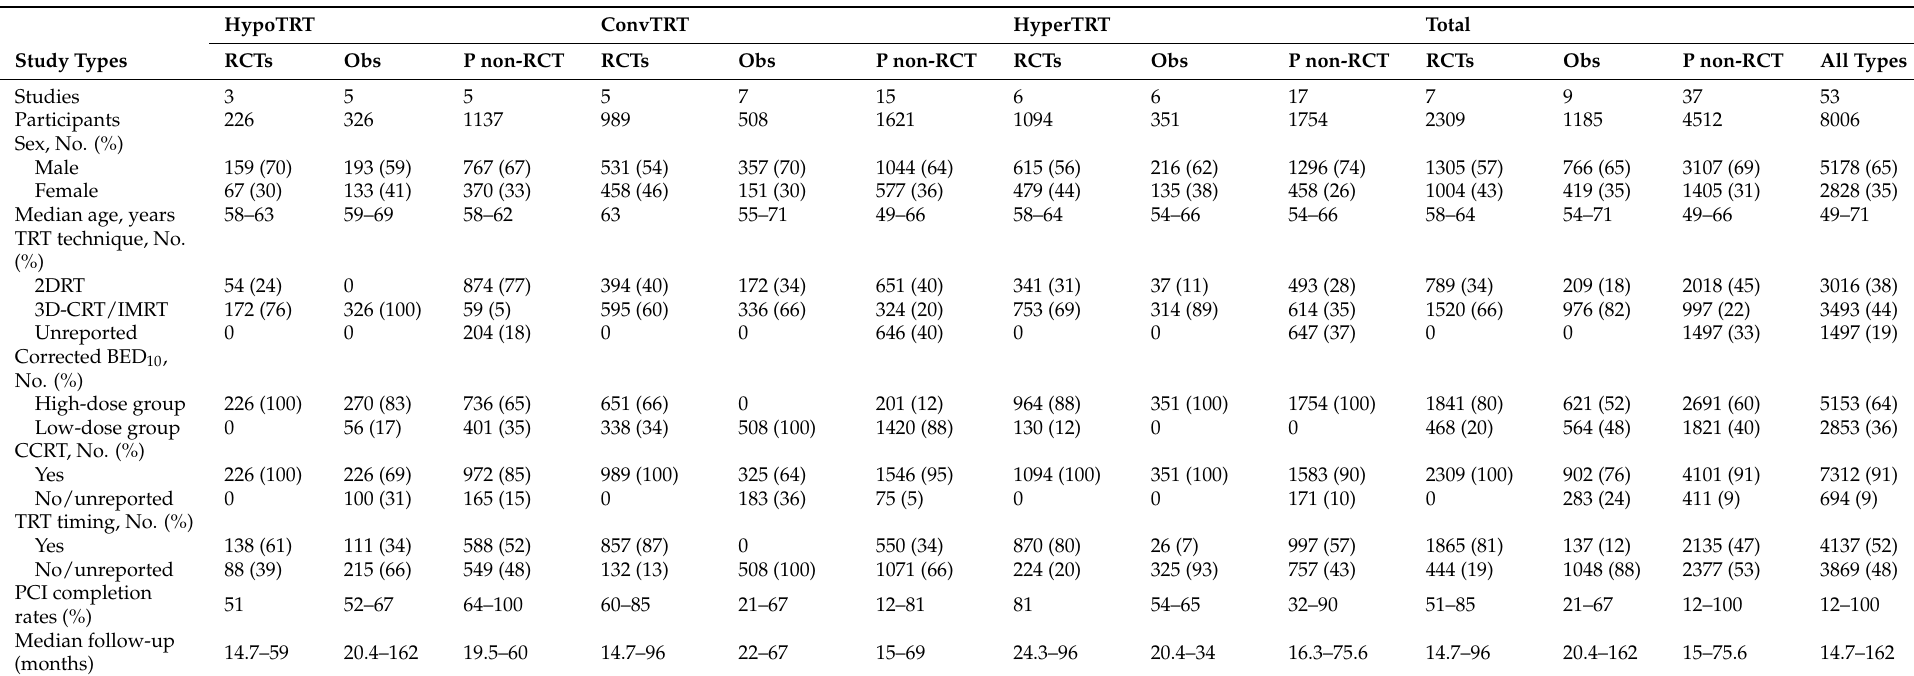
Table 1. Characteristics of the studies and